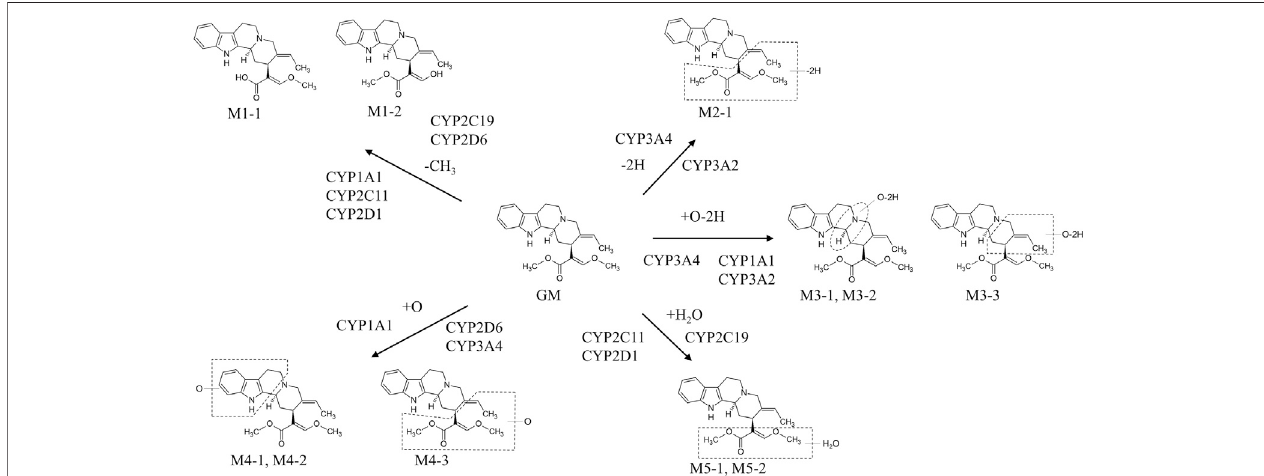
FIGURE2| In vitro metabolic pathways ofGM inratand humanmicrosomes. Themetabolic pathway ofGMisthesameinhumans and rats(Kushida et al.,2015). However, the CYP isoforms involved in each metabolic pathway differ between humans and rats (Matsumoto et al., 2016; Kushida et al., 2021). In humans, GM was dehydrogenated and/or hydroxylated by CYP3A4, demethylated or hydrated by CYP2C19, and demethylated or hydroxylated by CYP2D6. Of these CYP isoforms, CYP3A4-mediated hydroxylation is the major pathway of GM metabolism (Matsumoto et al., 2016). In rats, GM was dehydrogenated and/or hydroxylated by CYP3A2, demethylated and dehydrogenated and/or hydroxylated by CYP1A1, demethylated, hydroxylated, and hydrated by CYP2C11, and demethylated and hydrated by CYP2D1 (Kushida et al., 2021).